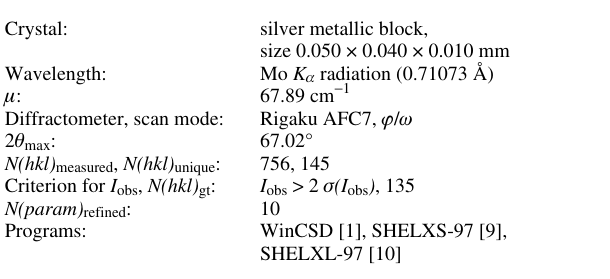
Table 1. Data collection and